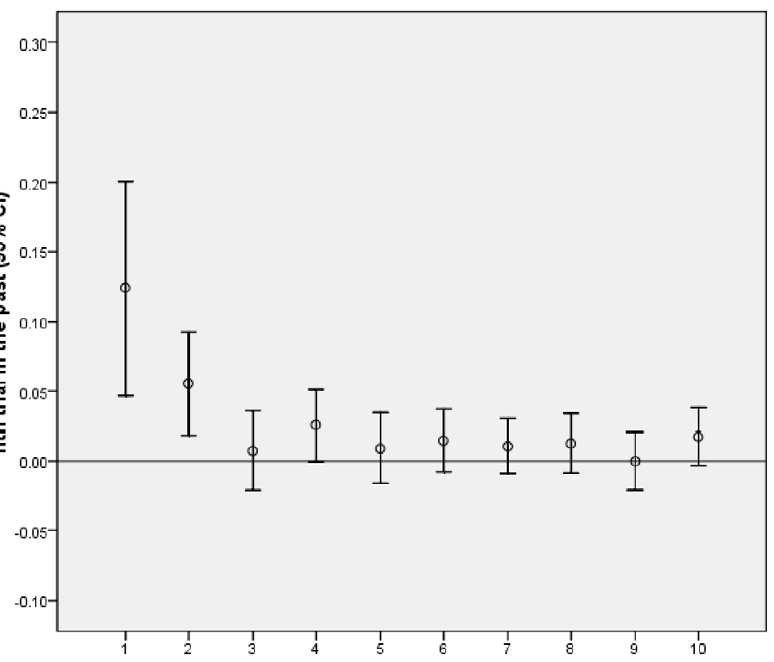
Figure 1. Results for testing whether learning is associative. Correlation of current prediction with what happened on the nth trial in the past plotted against trials into the past (n). Figure 1 shows the data for tone trials.